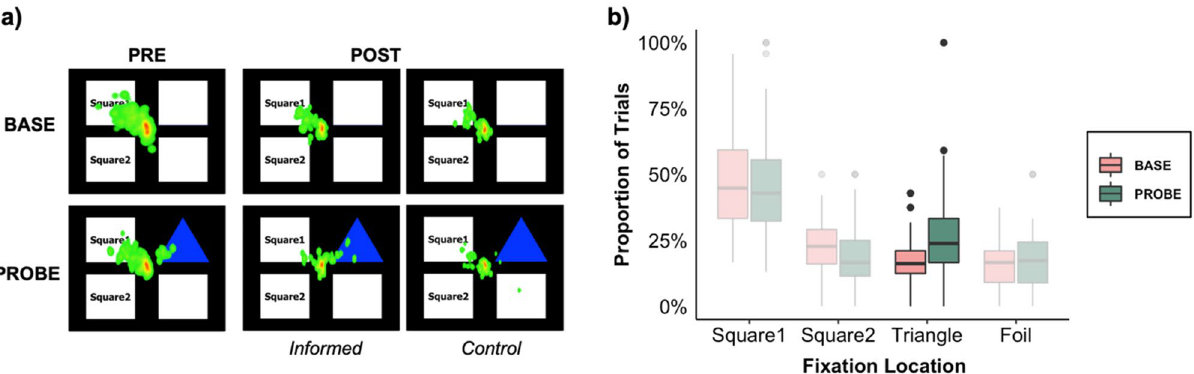
Figure 1. Gaze data during the LS-DS task. ( a ) All fixations, including those directed at the midline, that occurred prior to participants’ first response were compiled across all participants during the top left (Square1), bottom left (Square2), top right (Triangle) BASE and PROBE trial configurations, in PRE and POST trial blocks and ( b ) the proportion of PRE trials that participants fixated on each item, prior to using the LS, in BASE and PROBE